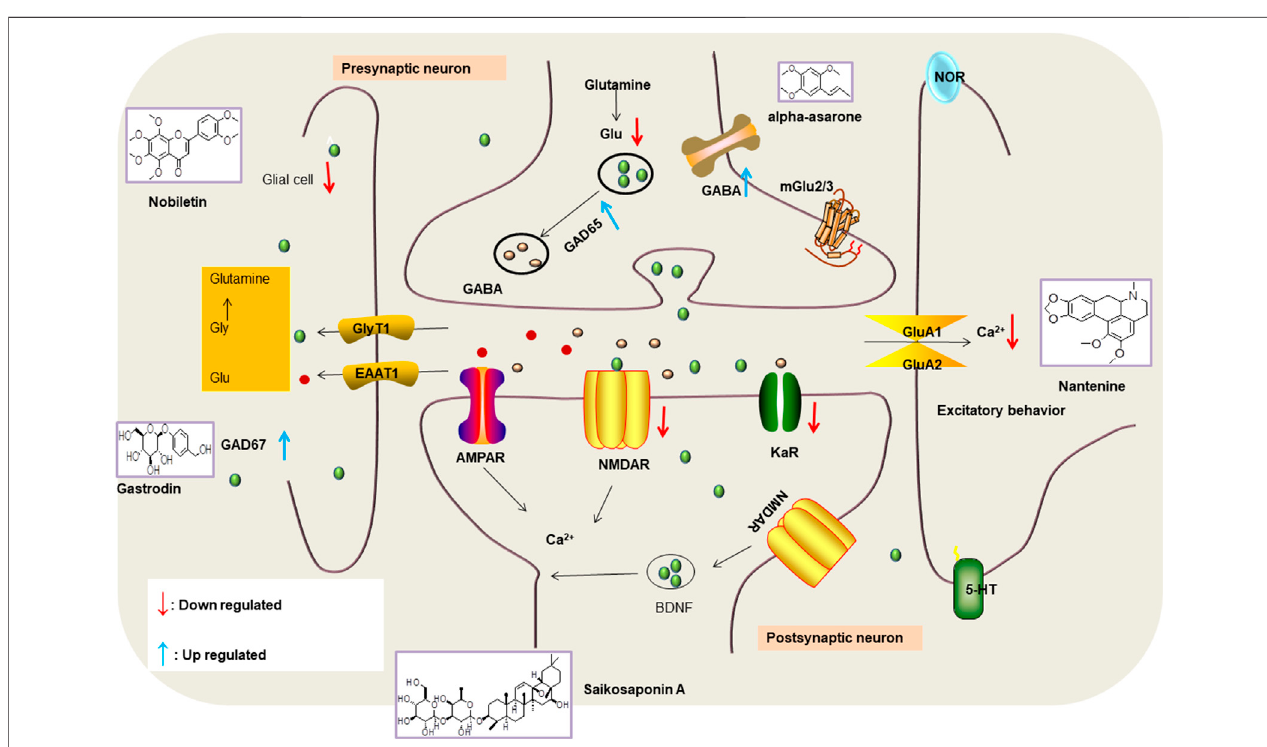
FIGURE 1 | Effects of natural drugs on receptor pathway. α -amino-3-hydroxy-5-methyl-4-isoxazolepropionic acid receptor (AMPAR), brain-derived neurotrophic factor (BDNF), excitatory amino acid transporter (EAAT), -aminobutyric acid (GABA), glutamate decarboxylase (GAD), glutamate (Glu), glycine (Gly), N-methyl-D- aspartate receptor